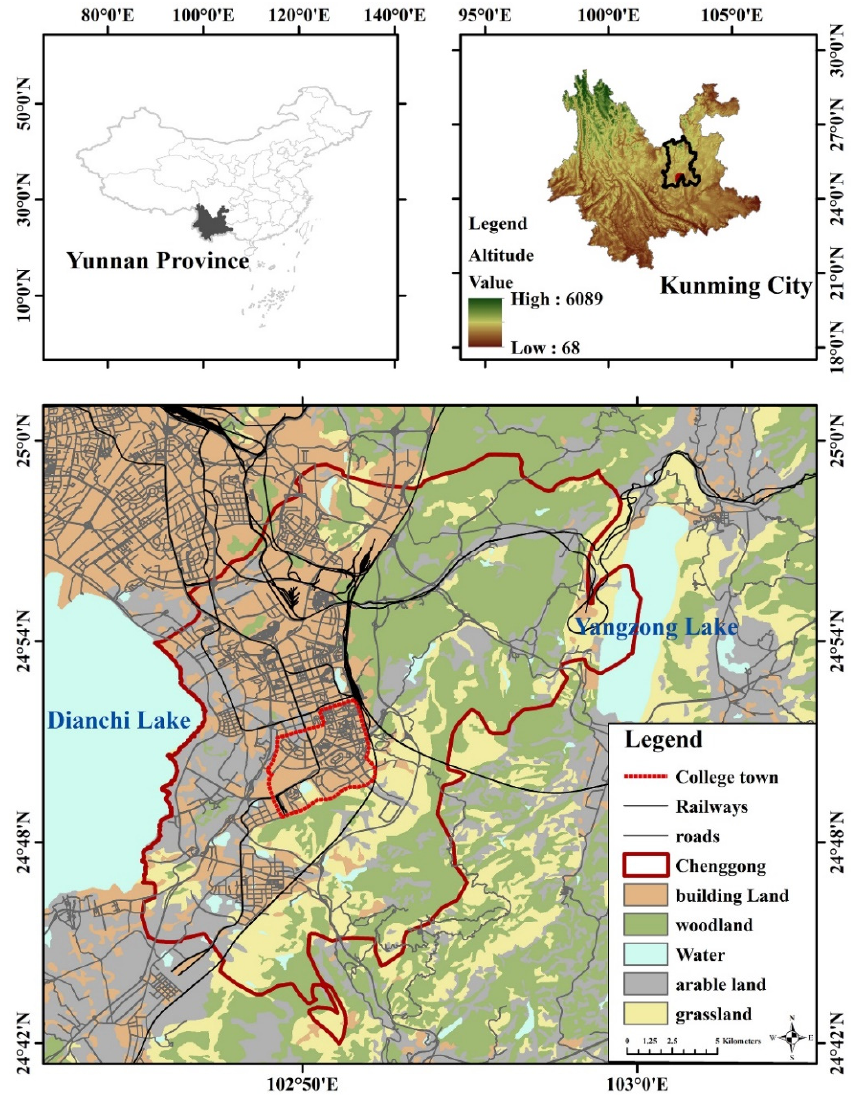
Figure 1. Study area. Note: The administrative boundary data in the figure comes from the National Geomatics Center of China (http://www.ngcc.cn/ngcc/, access on 21 March 2022). The land use data comes from the Resource Environment Science and Data Center (https://www.resdc.cn/, access on 21 March 2022) 30 m land use data for 2018. Road and track data comes from OpenStreetMap at https://www.openstreetmap.org/ (access on 26 October